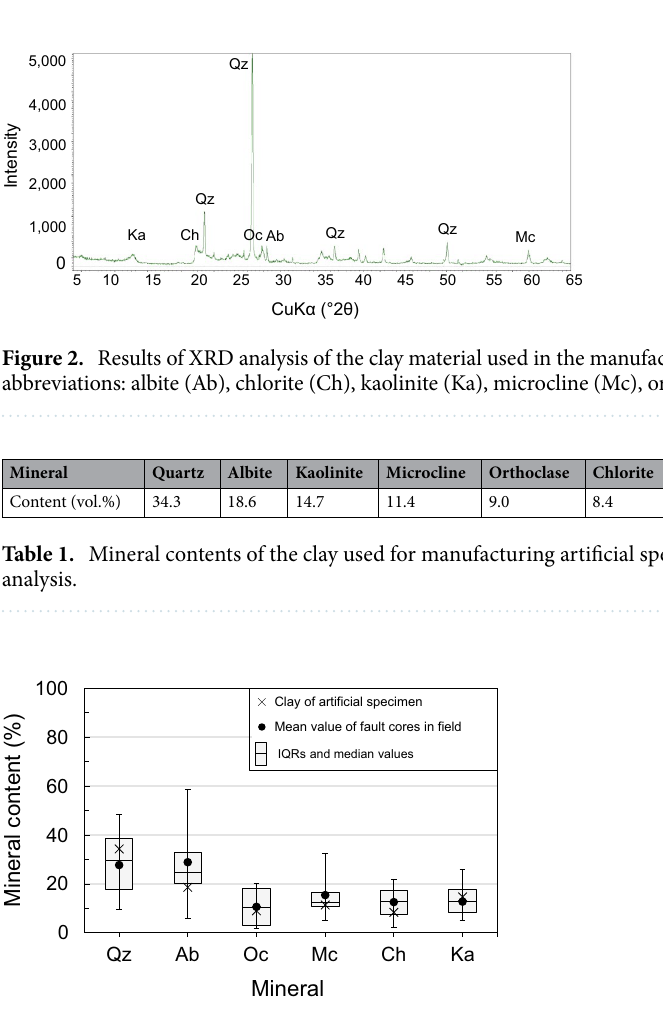
Figure 3. Box plots showing the mineral contents of 40 fault-core-zone clays sampled from the field and mineral contents of the clay material used for artificial specimen manufacture superimposed on the box plots. The boxes are inter-quartile ranges (IQRs). Mineral abbreviations: albite (Ab), chlorite (Ch), kaolinite (Ka), microcline (Mc), orthoclase (Oc), and quartz (Qz).